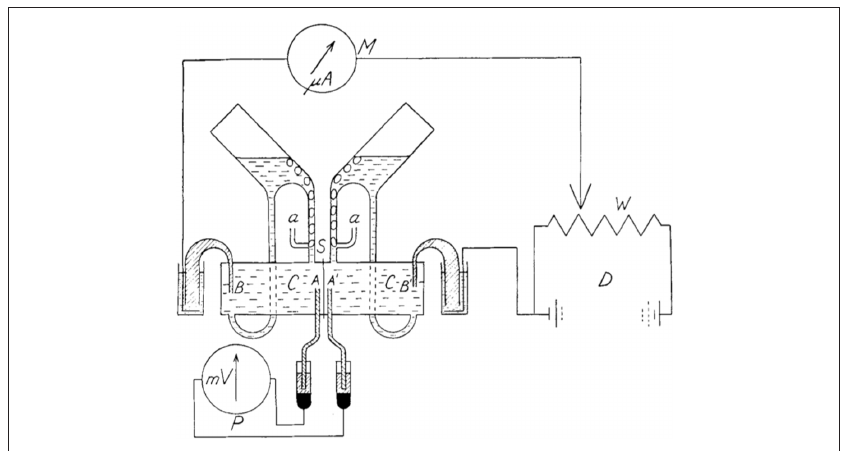
Figure 1 | Diagram of the ussing chamber apparatus. Abbreviations are: A and A ′ are voltage-sensing electrodes; a are the air lines to aerate the frog skin; B and B ′ are current-passing electrodes; C are the two half-chambers; S is where the skin is inserted between the half-chambers; D is the battery and W the potential divider that are used to adjust (by using current) the voltage across the skin to be equal to zero (i.e., short-circuited) as measured by P the potentiometer (voltmeter); any current-passing the skin while the skin is short-circuited is measured by M the microammeter and is the short-circuited current (μ A ), thus, active transport. The reproduction of Figure 1 from Ussing and Zerahn (1951) is with kind permission from John Wiley and